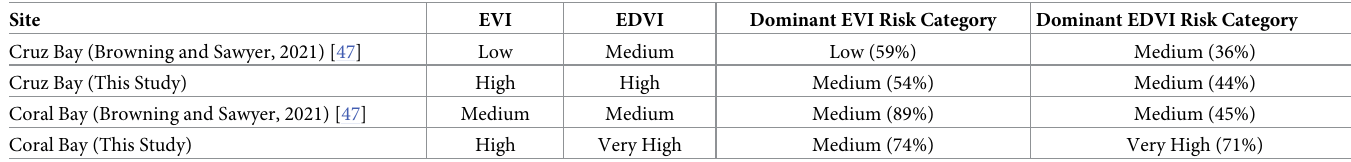
Table 3. Summary results and comparison of applying the high-resolution EVI/EDVI approach described in this study relative to the global EVI/EDVI approach (Browning and Sawyer, 2021 [47]). Erosion Vulnerability Index (EVI). Erosion and Development Vulnerability Index (EDVI). Site